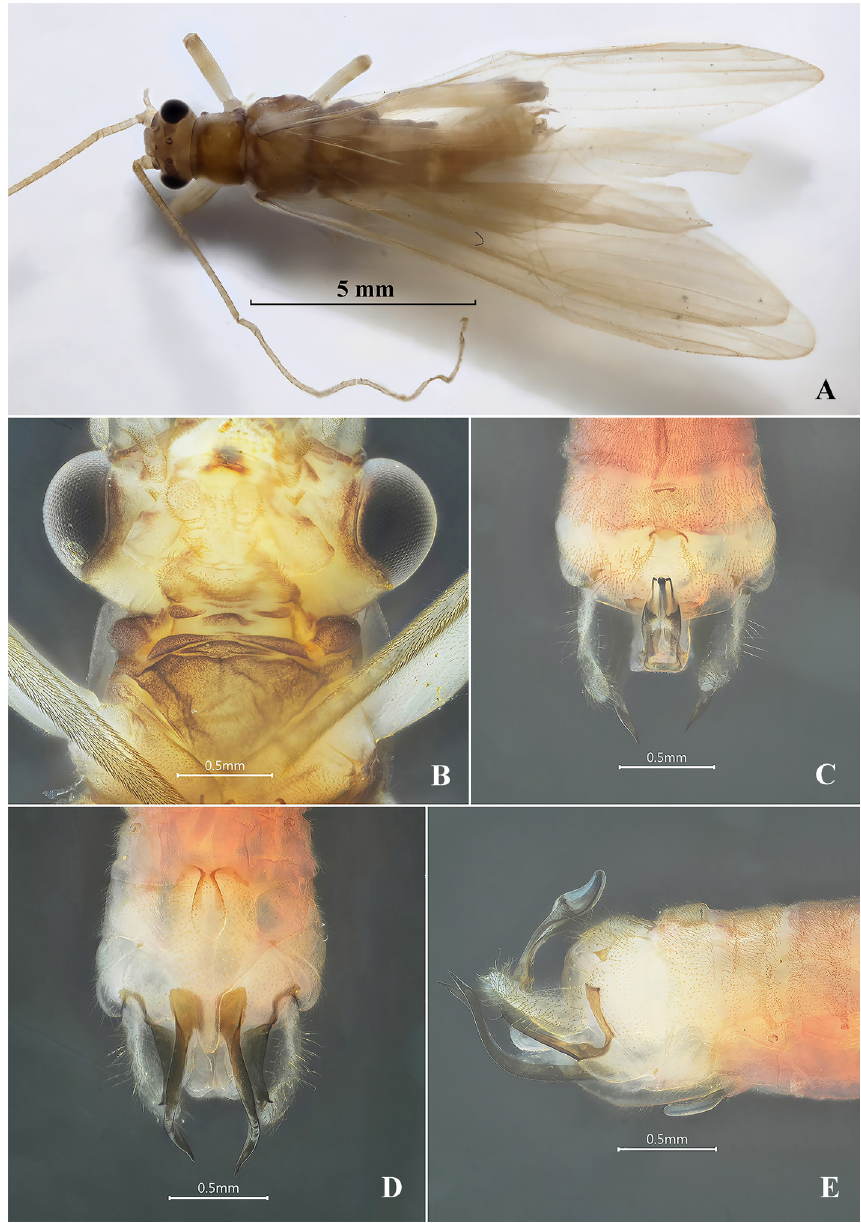
Fig. 2. Indonemoura longihamata Bai & Qian sp. nov., holotype, ♂ (SWFU). A . Habitus, dorsal view. B . Head and prothorax, ventral view. C . Terminalia, dorsal view. D . Terminalia, ventral view. E . Terminalia, lateral